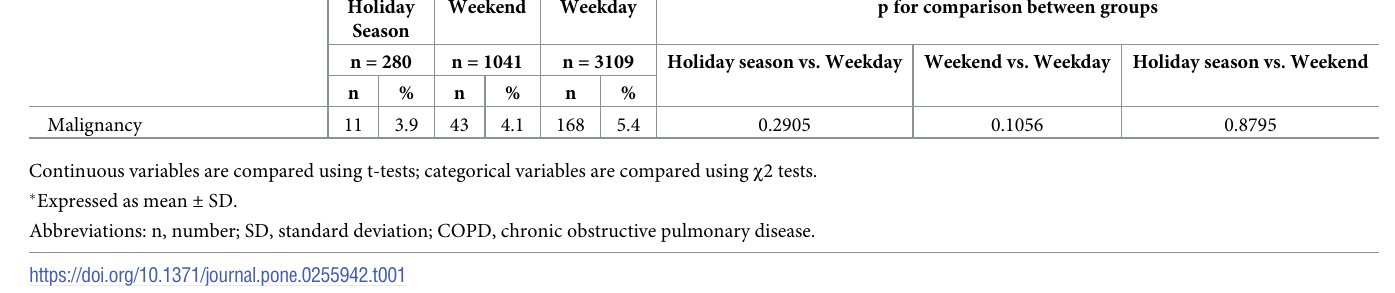
Table 2. Mortality risks for the patients admitted for acute aortic dissection during the holiday season, weekends, and weekdays. Outcome